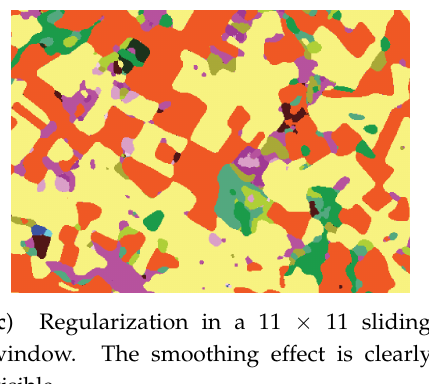
Figure 4. Regularization (majority vote filtering) in increasingly large sliding windows shows the smoothing of round